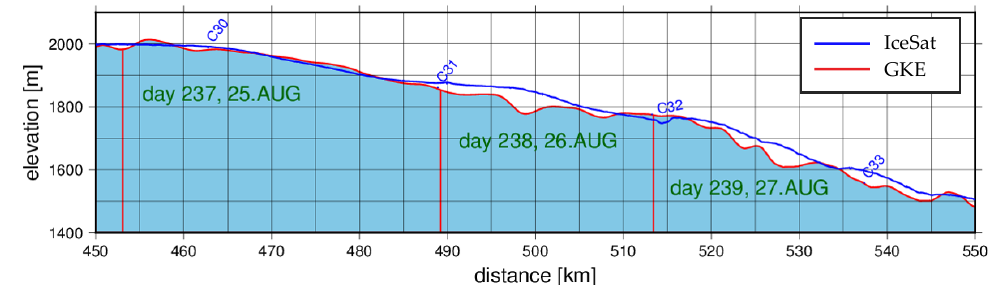
Figure 16. Part of the elevation profile from the west side (2015).